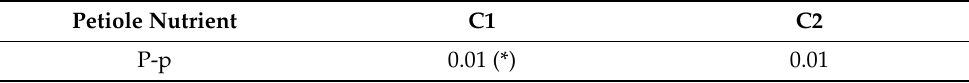
Table 4. Mean differences in planned contrasts (C1 and C2) on the petiole phosphorus content (P-p). The results were significant at * p <